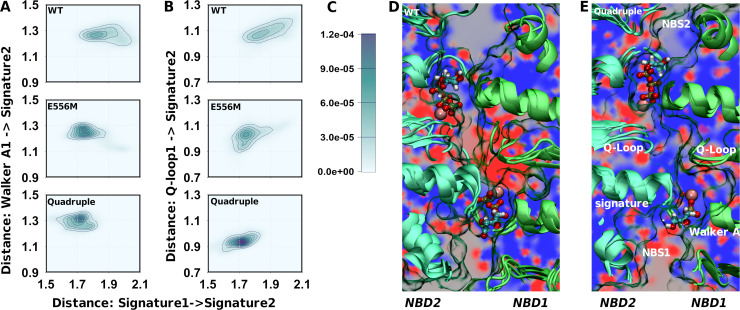
Structural changes in the NBD interface associated with NBS1 mutations.(A) Two dimensional probability distribution of distances: the x-axis reports on the distance between the signature sequences of NBD1 and NBD2, the y-axis shows the distance across NBS1 between the Walker A motif (residue 434) and the signature sequence in NBS1 (residue 1178). (B) Two dimensional probability distribution of the distance within NBS1: the x-axis reports on distances between the signature sequences of NBD1 and NBD2, the y-axis measures distance within NBS1 between the Q-loop of NBD1 (residue 475 and 476) and the signature sequence in NBS1 (residue 1178). (C) Probability scale for panel A and B. (D) Visualization of the electrostatic potential (calculated using APBS without the presence of ATP and Mg2+) in a plane perpendicular to the main axis of ABCB1 and intersecting with both signature motifs. The electrostatic potential was averaged over the replicates of wild-type ABCB1 simulations (E) Electrostatic potential of the quadruple mutant as determined in panel C.